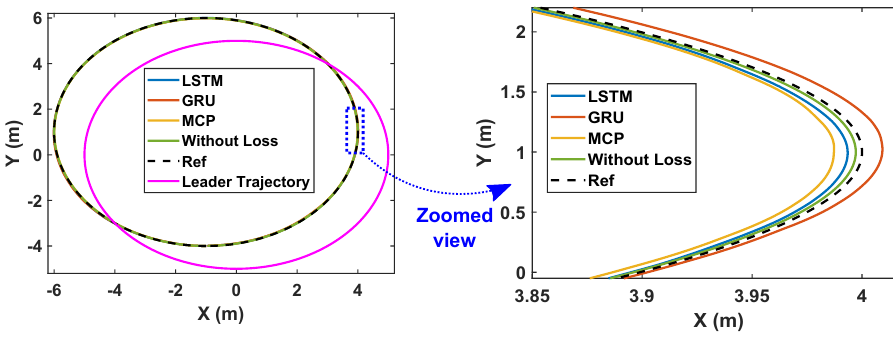
Figure 10. Trajectory of the robots during formation control (packet